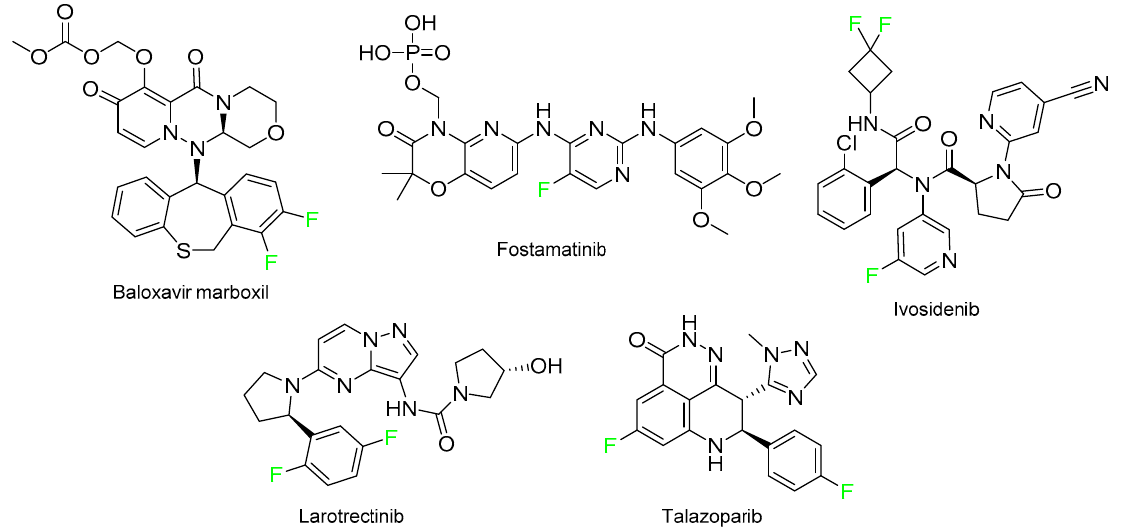
Figure 17. Structure of drugs containing fluoroaryl moieties.